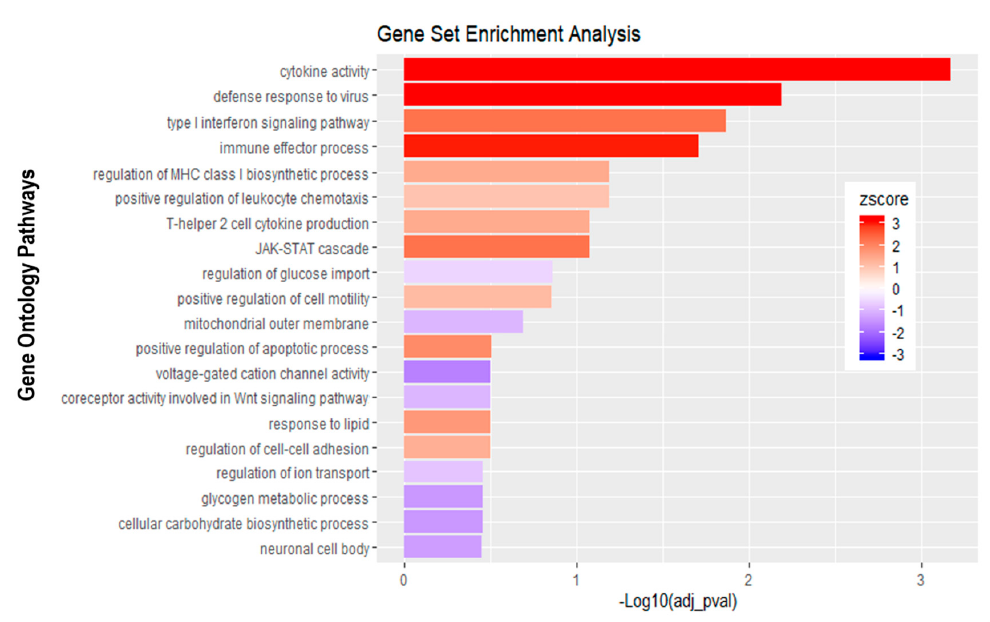
Figure 8. Gene set enrichment analysis of basolateral infection with E-30 MOI 0.7 versus inverted control. Bar chart representing the top 20 significantly enriched pathways in inverted E-30 MOI 0.7 infection compared to inverted control. Analysis was performed using KOBAS 3.0. This resulted in Benjamini–Hochberg corrected p -value and z-score (calculated as suggested by [26]). Int. J. Mol. Sci. 2020 , 21 , x FOR PEER REVIEW